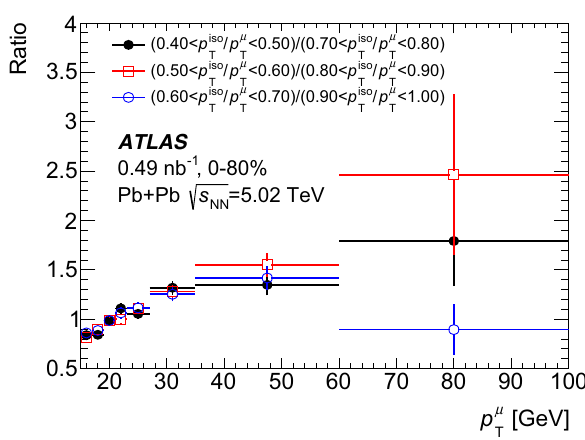
μ distribution shape for multi-jet background T